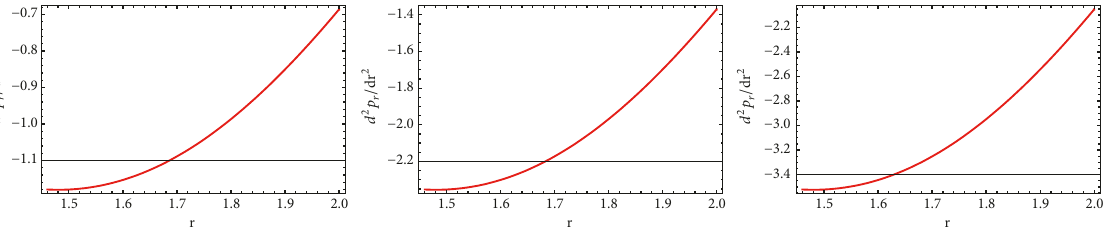
Figure 9: This figure represents the variation of 𝑑 2 𝑝 𝑟 /𝑑𝑟 2 versus 𝑟 (km) for the strange star taking 𝛽 = 1 , 𝛽 = 2 , and 𝛽 = 3